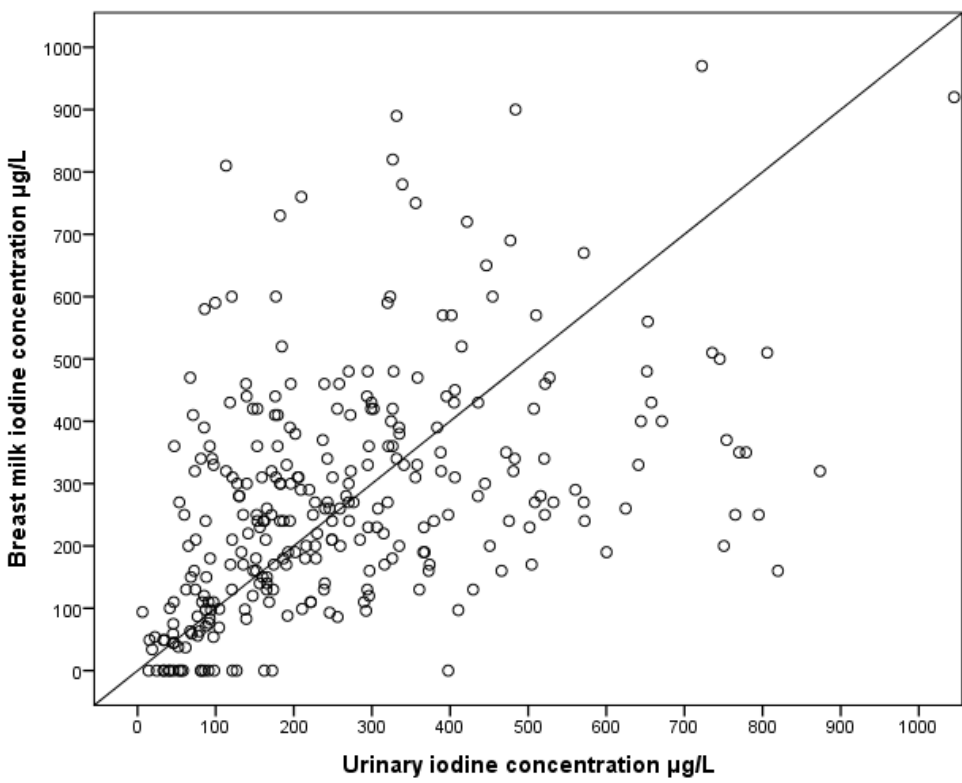
Figure 3. Correlation between UIC and BMIC, p < 0.001, r 2 = 0.20.